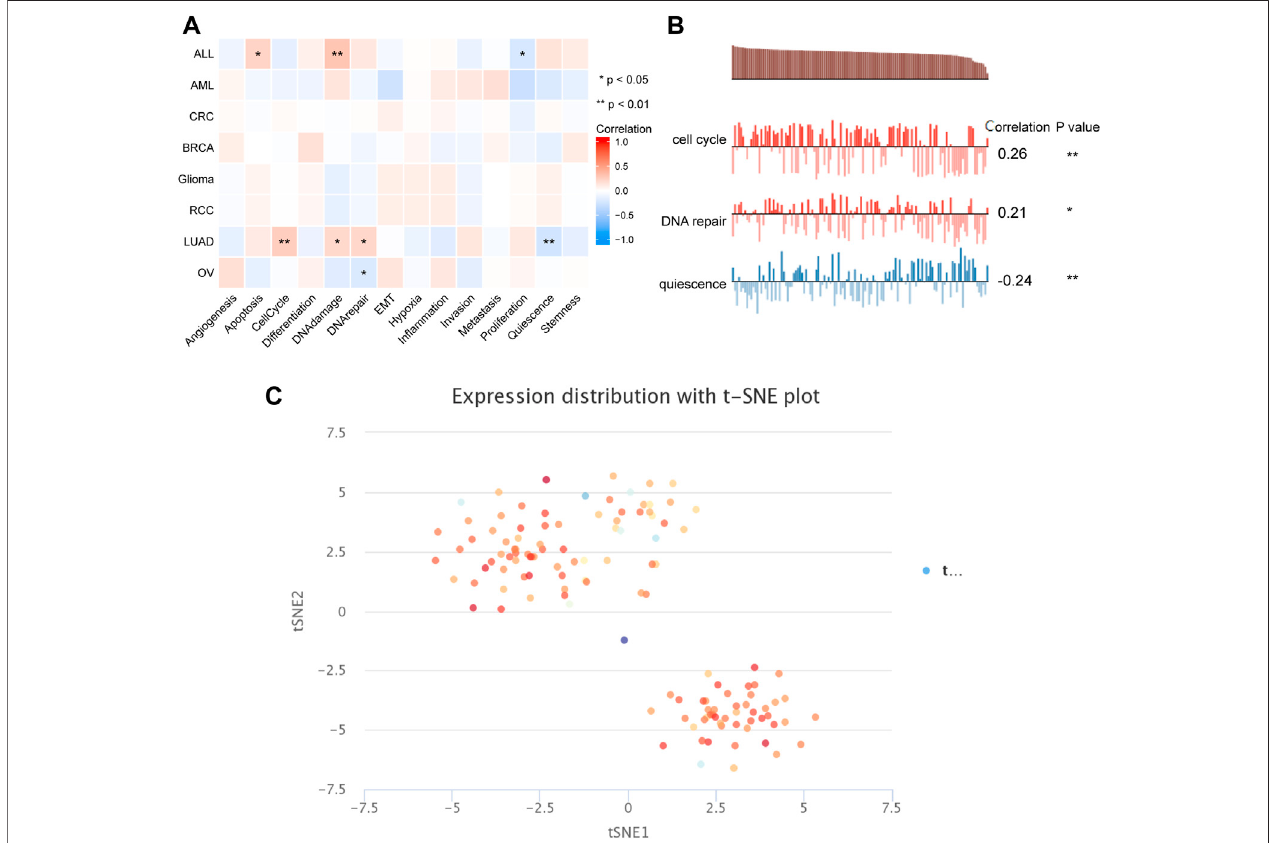
FIGURE 8 | The correlation between PSMD2 expression and cancer functional states. (A) A heatmap indicated the relationship between PSMD2 expression and cancer functional states from CancerSEA. (B) PSMD2 expression was correlated with cell cycle, DNA repair, and quiescence in lung adenocarcinoma. (C) The t-SNE diagram described the PSMD2 expression pro fi le in single cells of lung